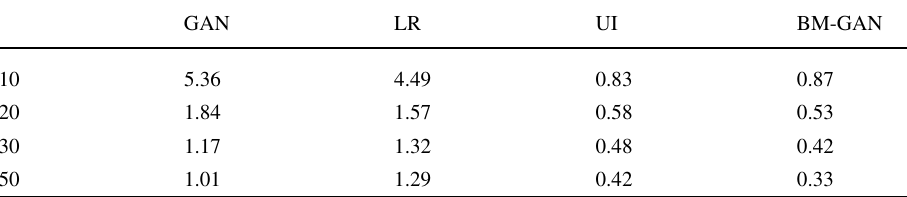
Table 1 The ARE between the generated data and the real data of TIEDVD for different samples